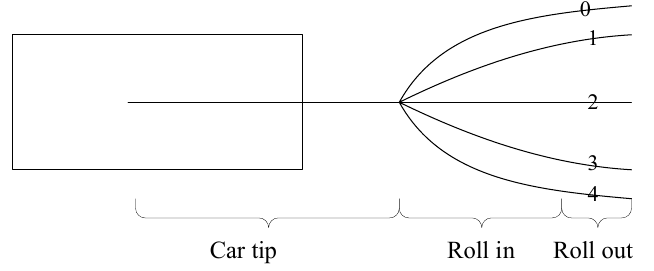
Figure 5. Components of rollouts.